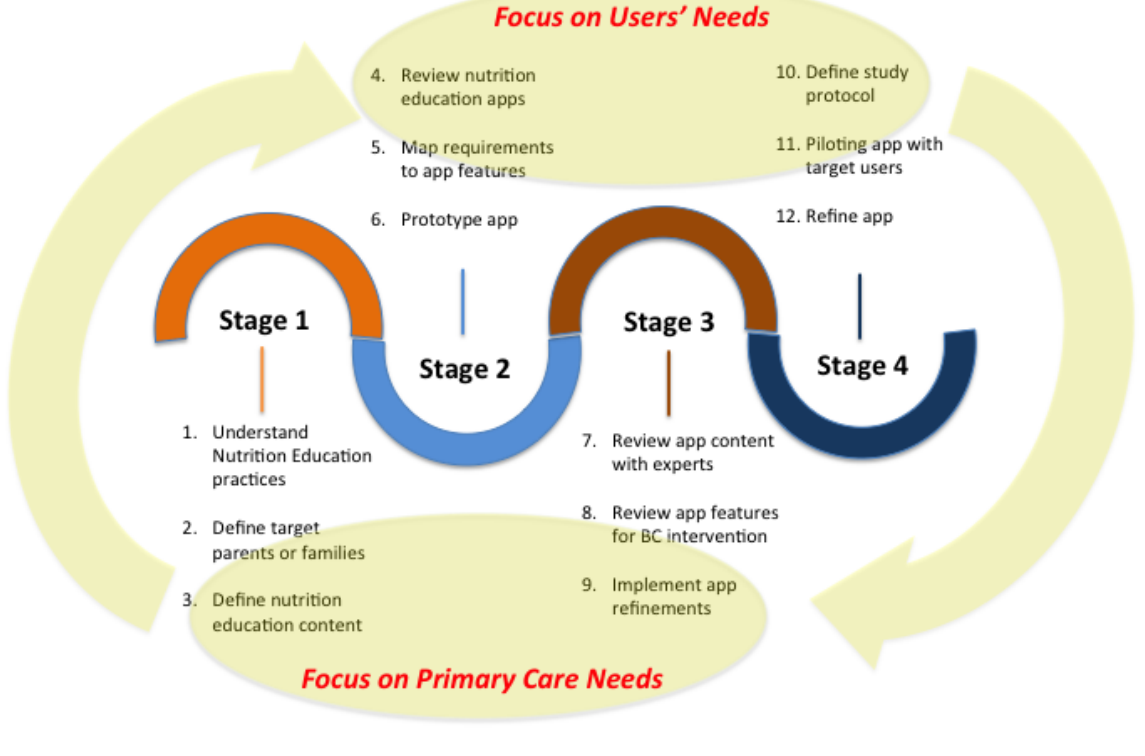
Figure 1. The design and development stages of the mHealth app intervention. BC: behavior